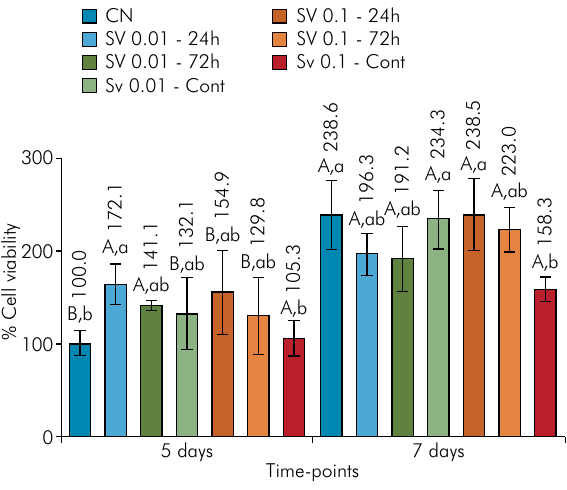
Figure 3. Mean and standard deviation of ALP activity values (%) for each experimental group at the set time points. Uppercase letters allow comparison among the time points for each experimental group. Lowercase letters allow comparison among the groups within each time point. Different letters show significant differences (n=6; tests: ANOVA and Tukey; p < 0.05).